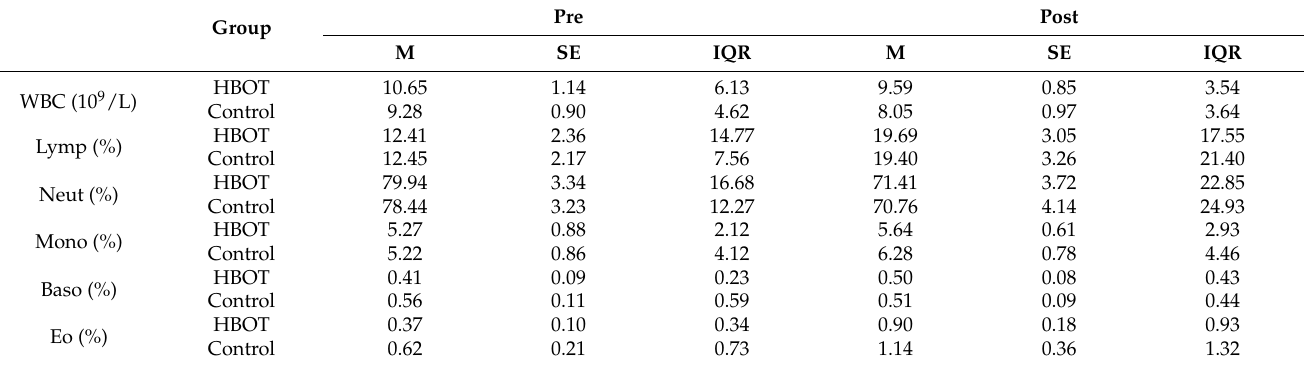
Table 3. CBC for input and output results.